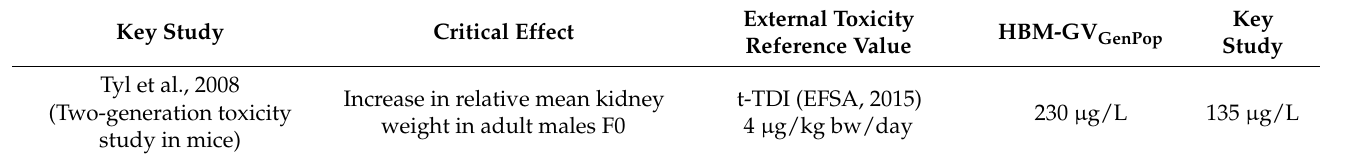
Table 1. HBM-GVs calculated for the general population for total BPA in